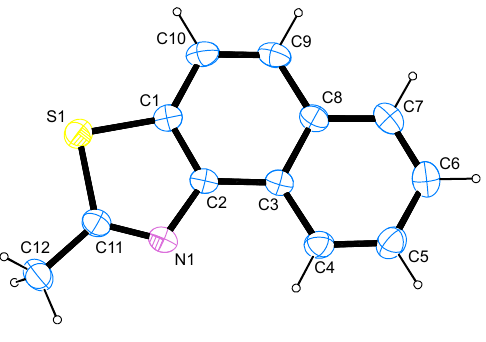
Table  : Data collection and handling.